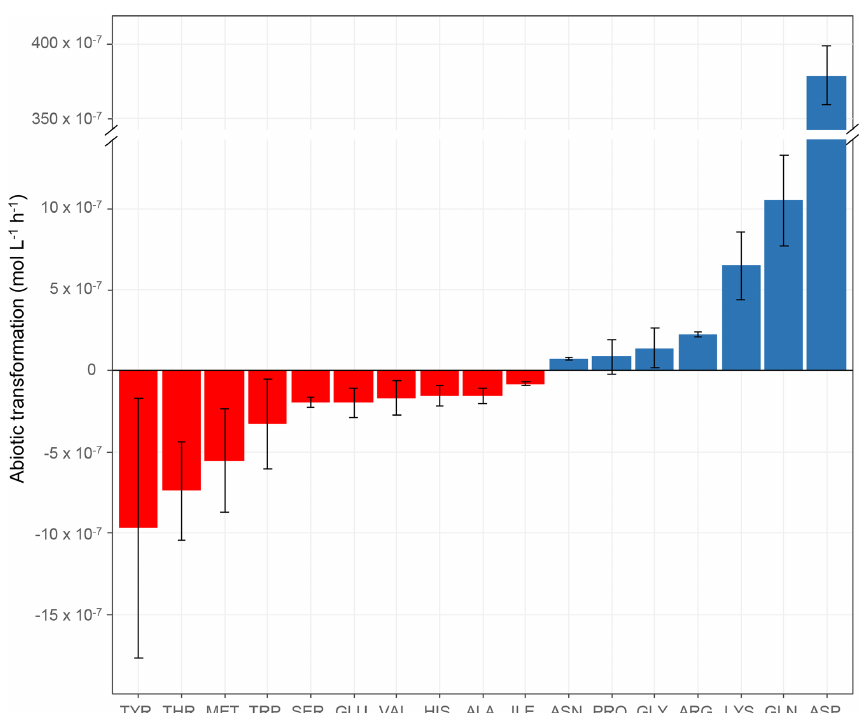
Figure 2. Abiotic transformation rates (molL − 1 h − 1 ) obtained for each amino acid in microcosms containing the mixture of the 19 AAs in an artificial-cloud medium under irradiation in the presence of Fe(EDDSS) as source of OH radicals. The standard error bars reflect the variability measured from three triplicates (independent experiments). Negative values represent abiotic degradation, while positive values represent abiotic